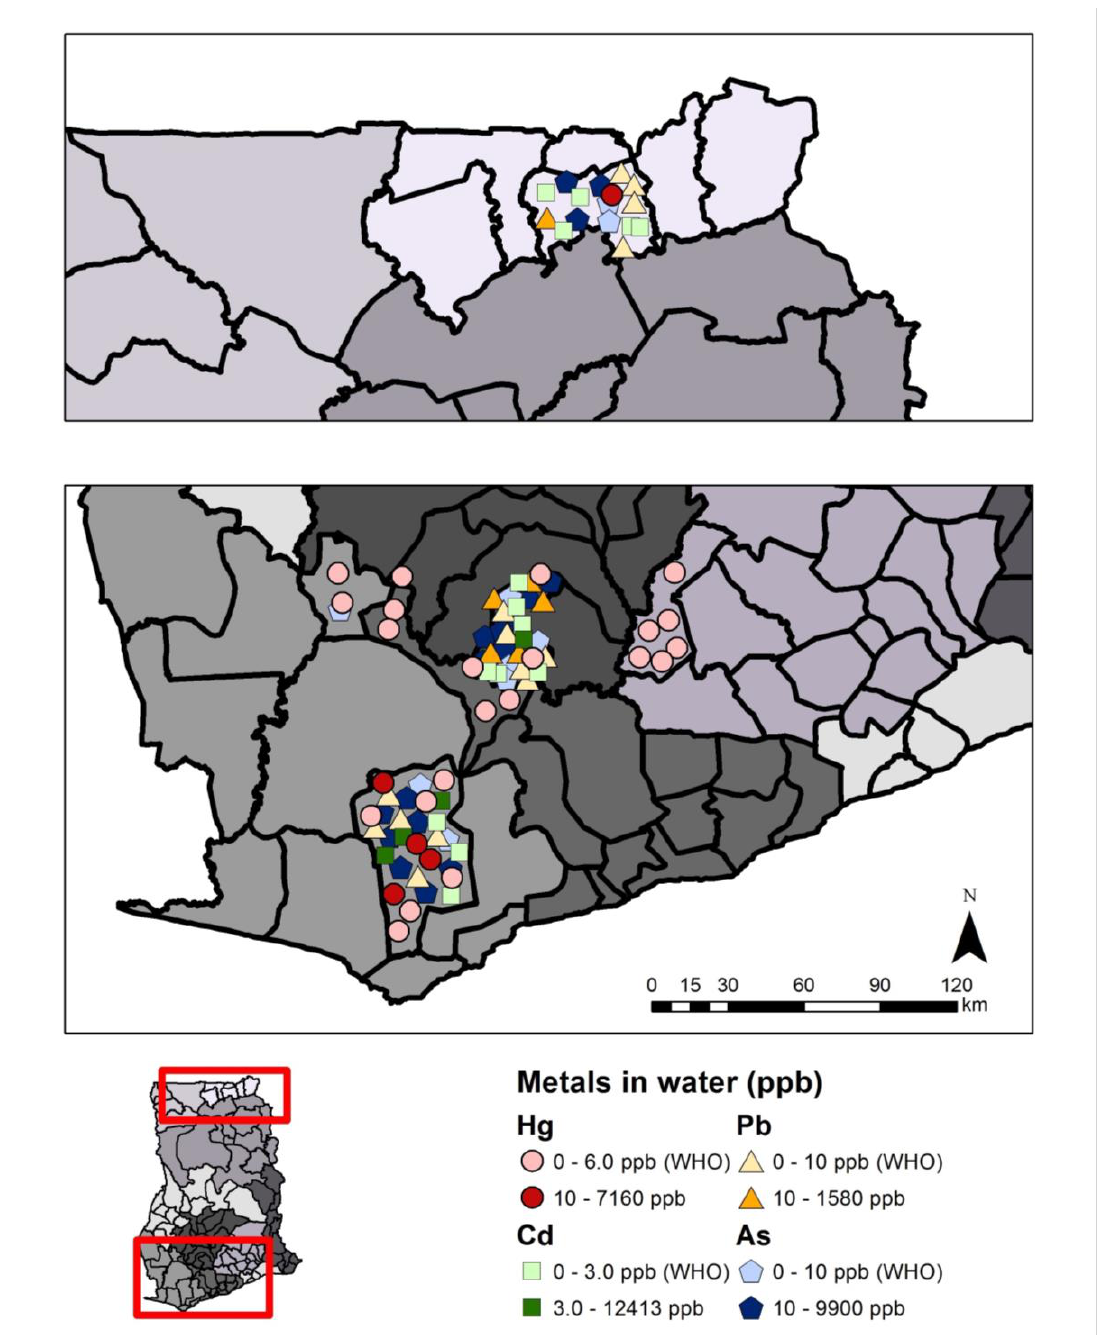
Figure 8. Metals in surface/groundwater samples in southwest (bottom panel) and northeast (upper panel) Ghana. Each symbol represents the mean metals value (µg/L or ppb) from a single study in that region, and for illustrative convenience the symbols are scattered randomly within the district where the sampling took place. Political regions are distinguished by different shades of grey. Mean total mercury (Hg), lead (Pb), cadmium (Cd), or arsenic (As) above or below guidelines are